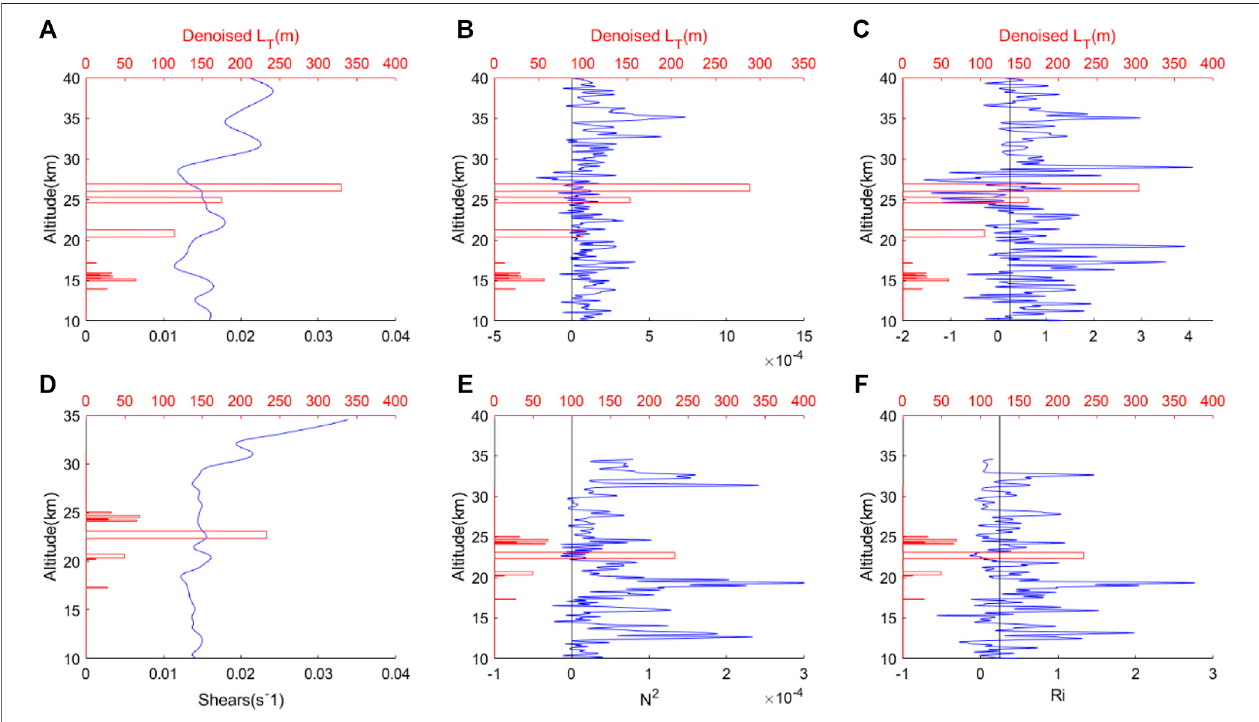
FIGURE 5 | The pro fi le of Thorpe scale, Wind shear, Buoyancy frequency, Richardson number above the tropopause ( A – C are calculated from sounding data at 13:00; D – F are calculated from sounding data at 20:00; solid red lines are Thorpe scales; solid blue lines from left to right are wind shear, buoyancy frequency and Richardson